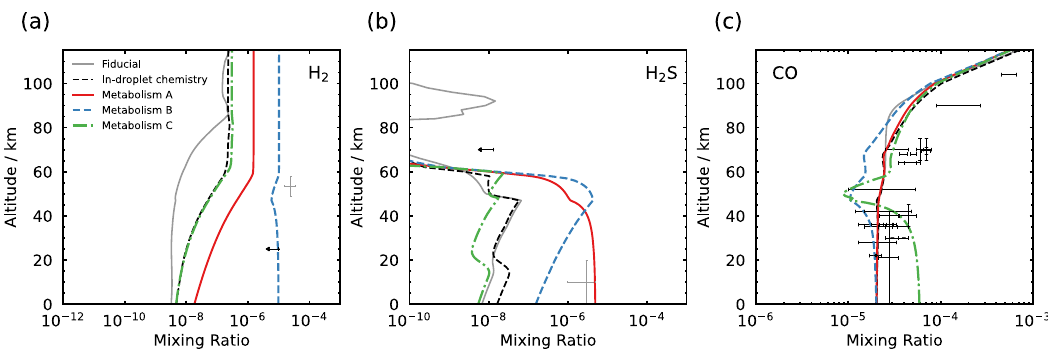
Fig. 3 Atmospheric pro fi les resulting from the maximum limit of metabolic activity within observational constraints. Atmospheric pro fi les of ( a ) H 2 , ( b ) H 2 S and ( c ) CO mixing ratios as a function of altitude for the fi ducial model and droplet-chemistry (abiotic) model 6 , compared with the three proposed metabolic models at the limit of violating an observational constraint in the atmosphere. Observational data and their 1 σ errors are shown in black except for the observation of H 2 S below 20 km altitude 35 , and the observation of H 2 at 50 km altitude 40 , which are shown in grey, as these are possibly spurious detections.